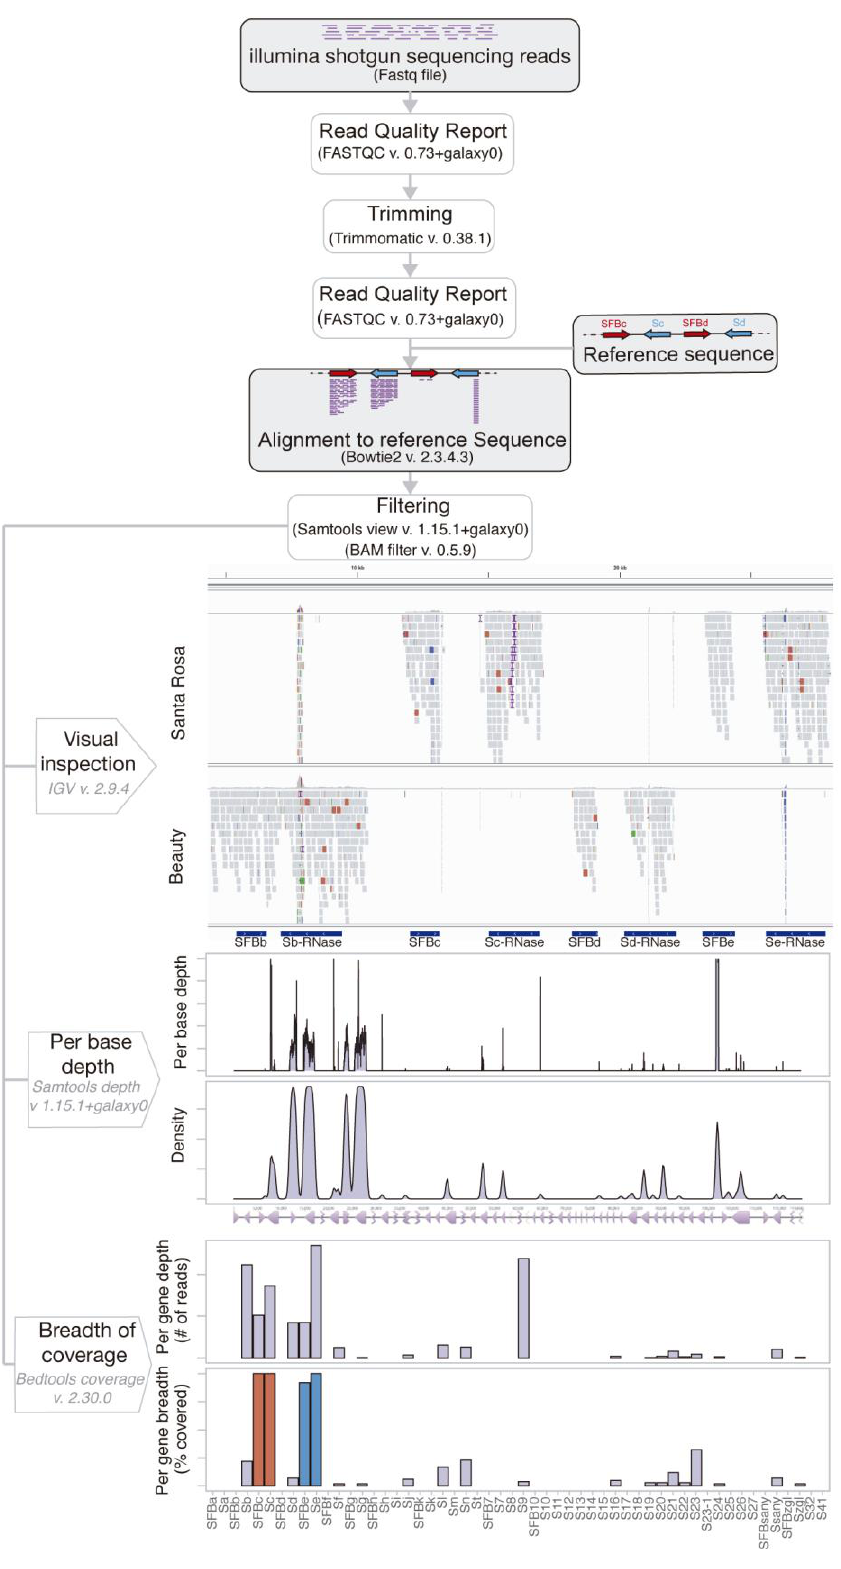
Figure 2. Bioinformatics pipeline for S -genotyping by high throughput sequencing. The visual inspection illustrates cultivars ‘Santa Rosa’ and ‘Beauty; the per base depth and per gene depth of the coverage illustrate the cultivar ‘Santa Rosa’ (see Figure S1 for all genotypes analyzed).